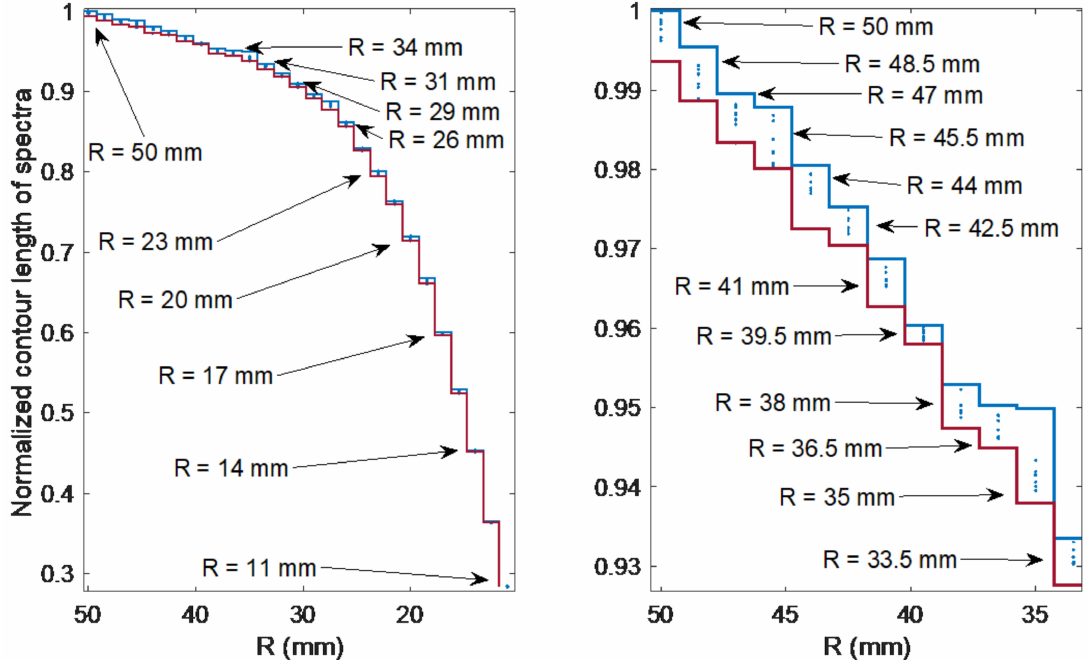
Figure 5. Changes in the spectral contour length under the influence of bending for 27 bending radii and for repeated